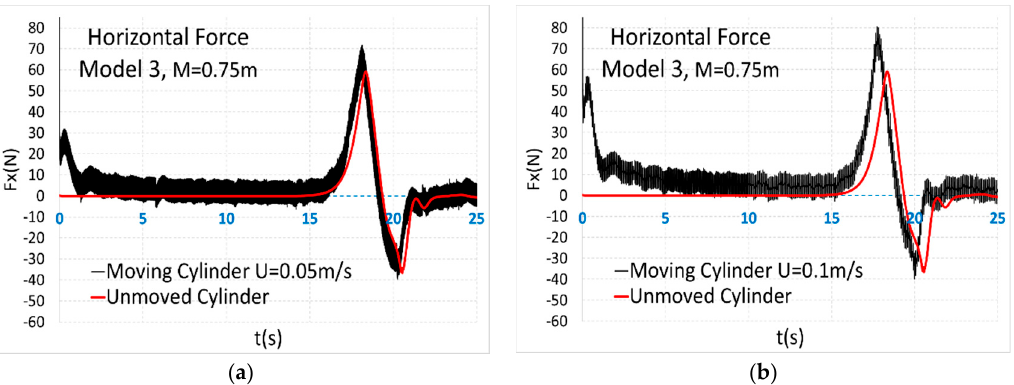
Figure 10. The time variation of the horizontal forces for model 3. ( a ) A comparison between the unmoved cylinder (red line) and the moving cylinder at U c = 0.05 m/s. ( b ) A comparison between the unmoved cylinder (red line) and the moving cylinder at U c = 0.1 m/s.